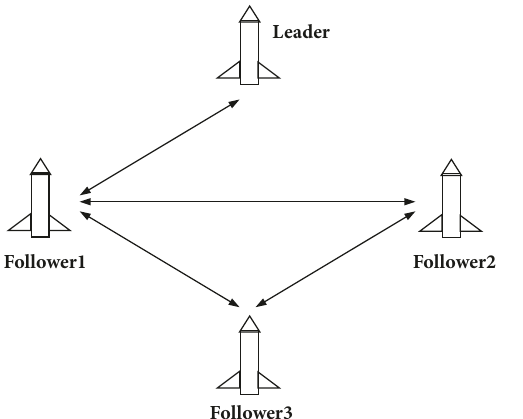
topologies is gradually consistent with that of the “leader.” Eventually, the “leader” and “follower” hit the target at the same time. The motion trail curve is smooth, showing short interception duration, fast convergence speed, and good